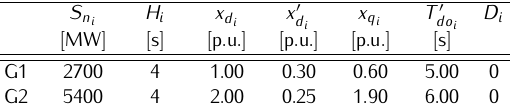
Table 2. A two-machine system parameters.